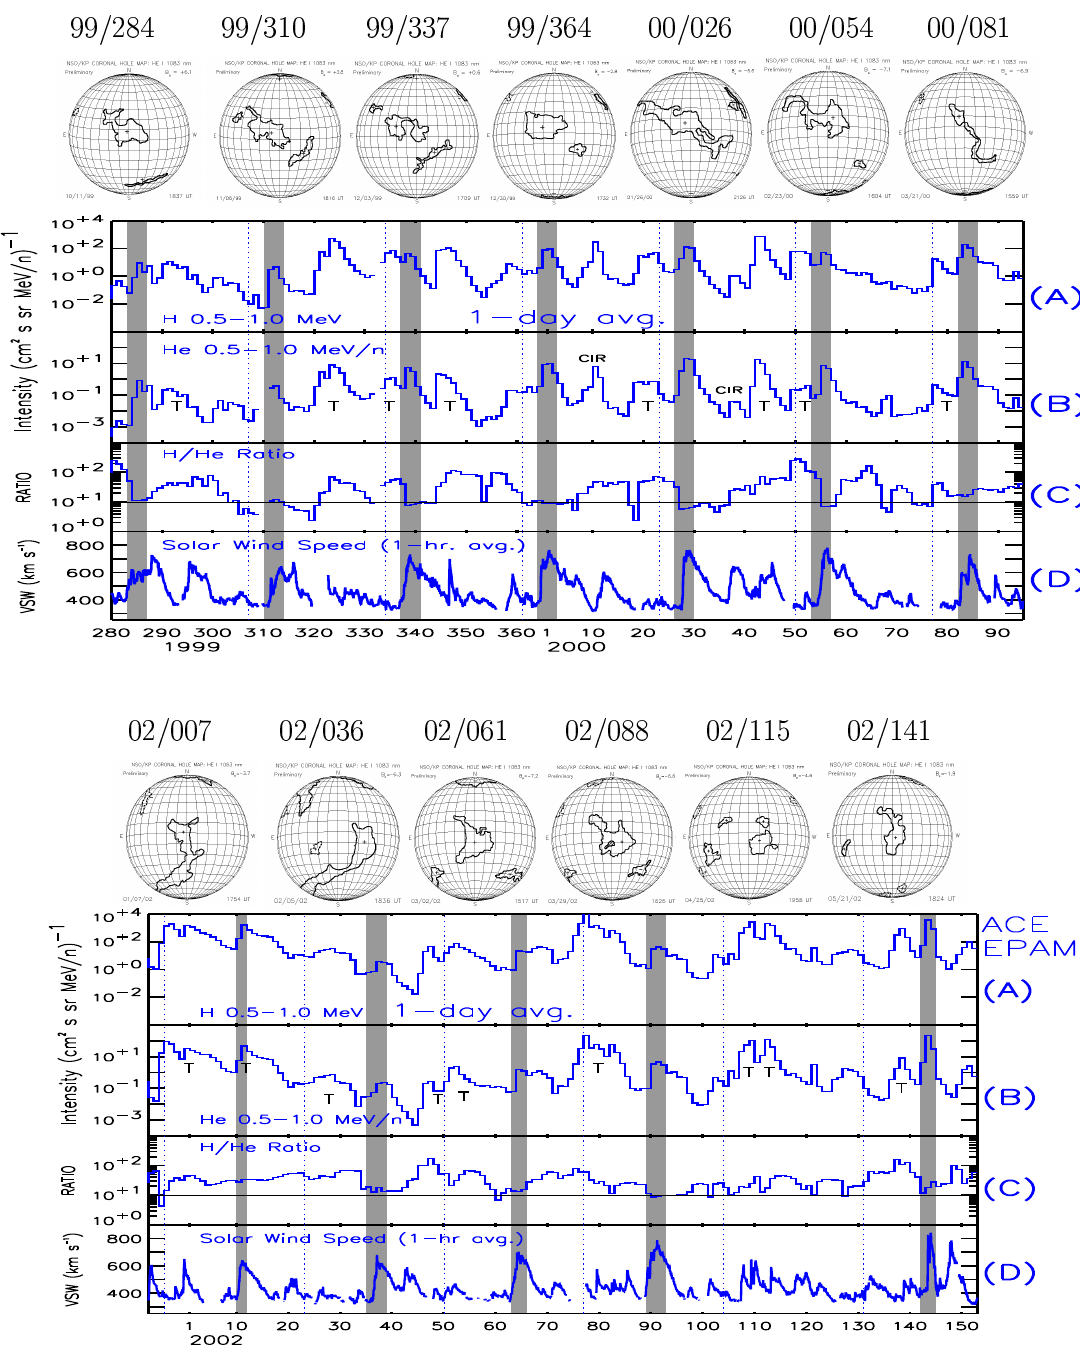
Fig. 9. Two sequences of corotating high-speed streams at ACE during solar maximum. The top graph covers the time interval from 7 October 1999 (day 280) to 4 April 2000 (day 95), and the bottom graph from 24 December 2001 (day 358) to 2 June 2002 (day 153). At the top of each graph we have included the coronal hole 1083 nm maps provided by the National Solar Observatory at Kitt Peak taken on the indicated day. (A) Daily averages of the 0.5–1.0 MeV proton intensity and (B) daily averages of the 0.5–1.0 MeV/nucleon helium intensity as measured by the EPAM instrument (Gold et al., 1998). (C) H/He ratio between the daily averages intensities of H and He shown in panels (A) and (B). (D) Hourly averages of the solar wind speed as measured by the SWEPAM instrument (McComas et al., 1998). Gray shadow bars identify the passages of recurrent CIRs over Ulysses. Vertical dotted lines are spaced every 27 days. In panel (B), transient events are identified by T